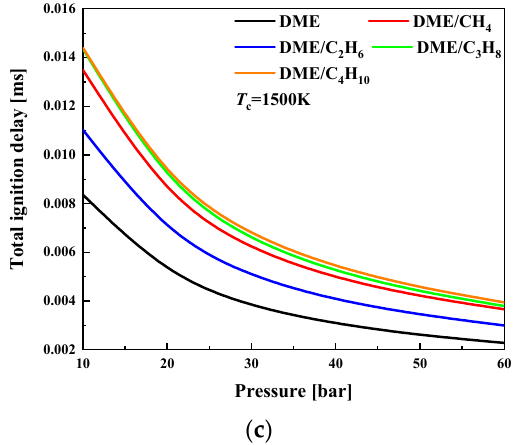
Figure 4. Ignition delay as a function of compressed pressures for various compressed temperatures at φ = 0.5: ( a ) T c = 650 K; ( b ) T c = 800 K; and ( c ) T c = 1500 K.